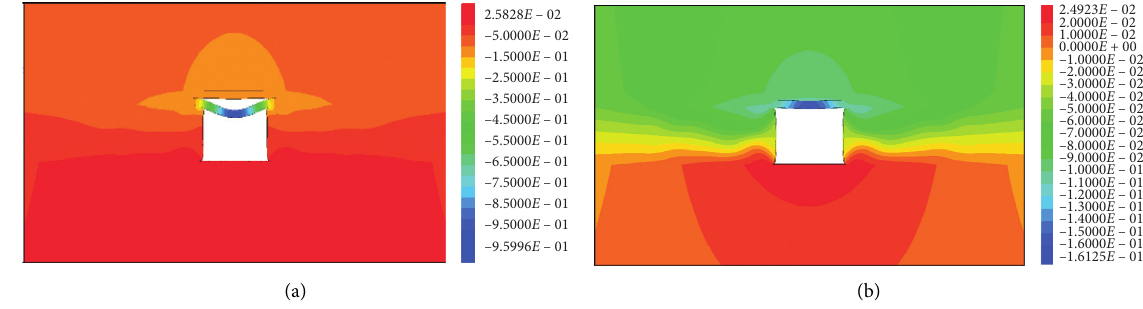
Figure 13: Roof sag of different rock-rock interfacial friction angle: (a) 10 ° and (b) 20 °